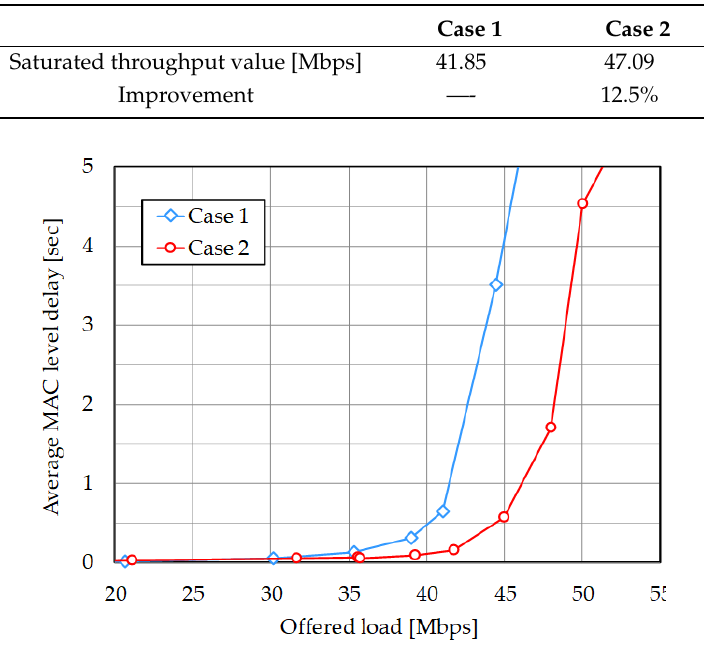
Figure 6. Average MAC level delay in simplified